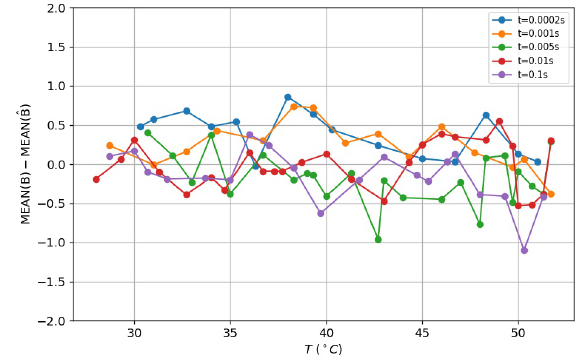
Figure 7. Dark level model error as a function of temperature and exposure time.